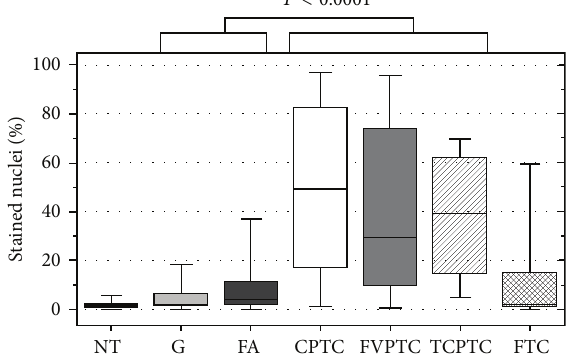
Figure 2: Box plot graph with the percentage of stained nuclei quantified by using ACIS III in all the studied thyroid